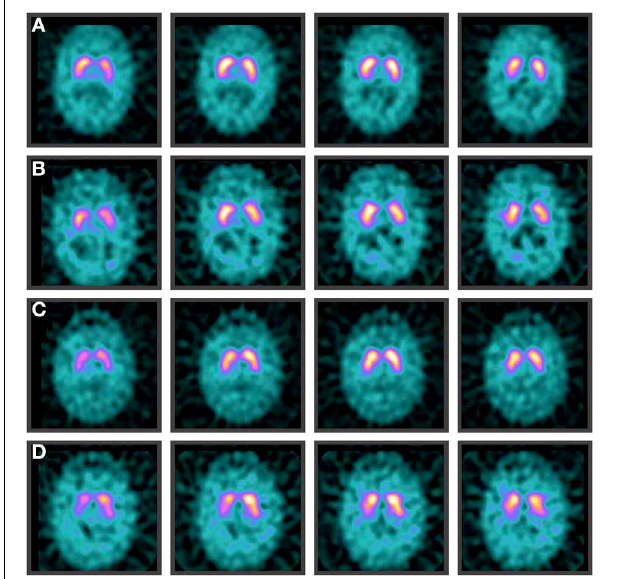
FIGURE 1 | Normal and abnormal DAT-SPECTs. Normal DaT-SPECTs of a patient with essential tremor at baseline (A) and 42 months later (B) . Normal DaT-SPECT of a patient with Parkinson’s disease at baseline (C) . However, 84 months later (D) the scan was abnormal due to a decrease in postsynaptic uptake on the right